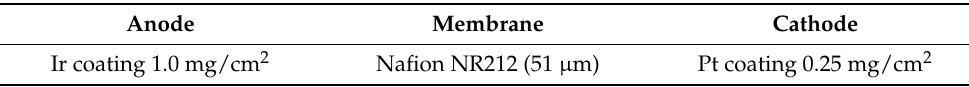
Table 2. Materials used in the construction of the